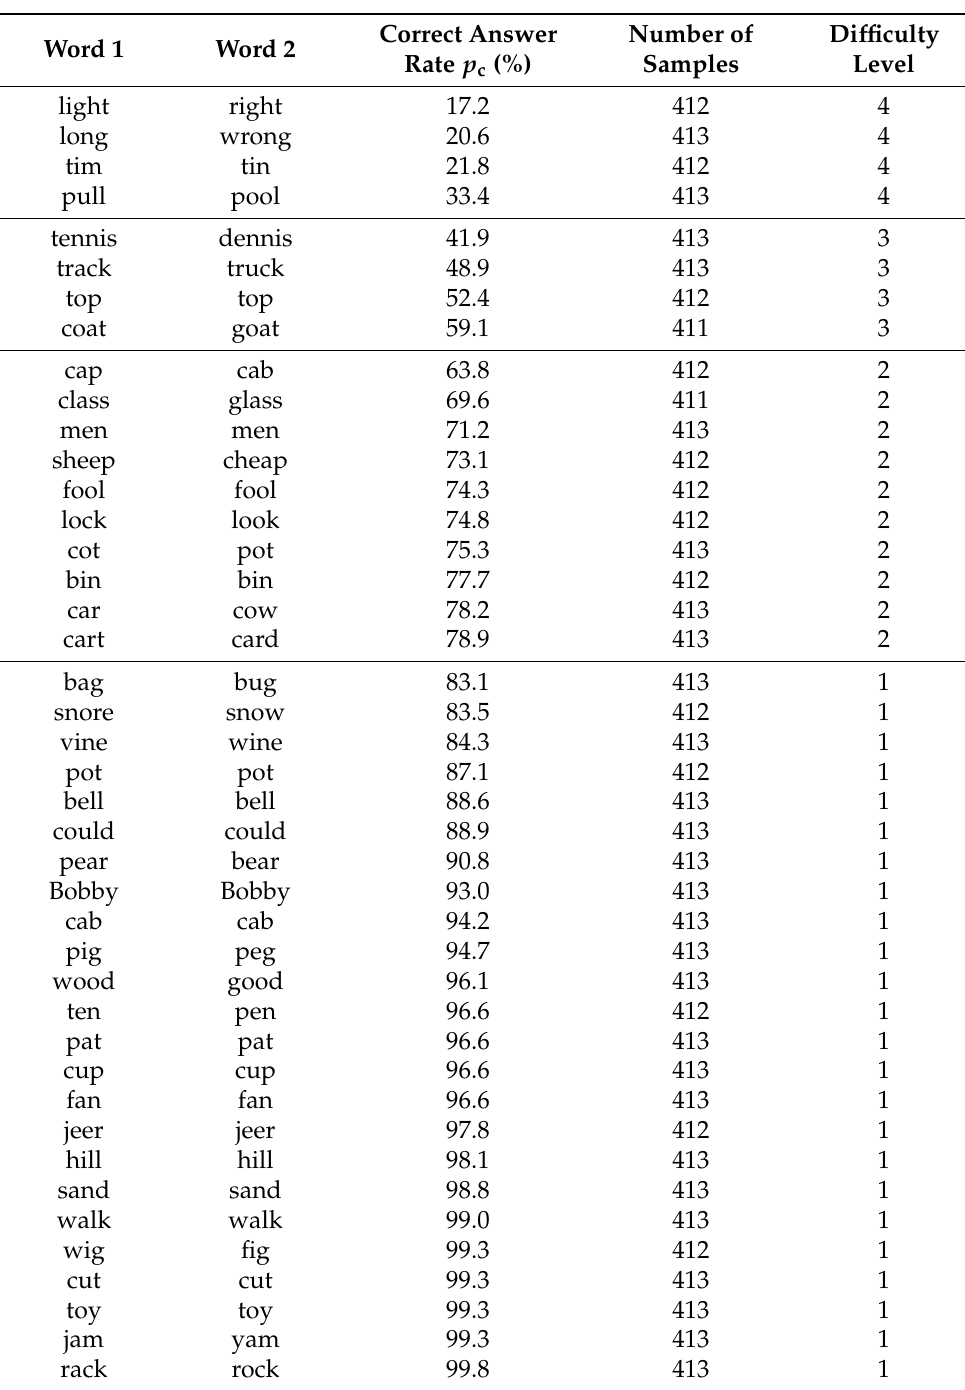
Table 5. Correct answer rate p c of each word